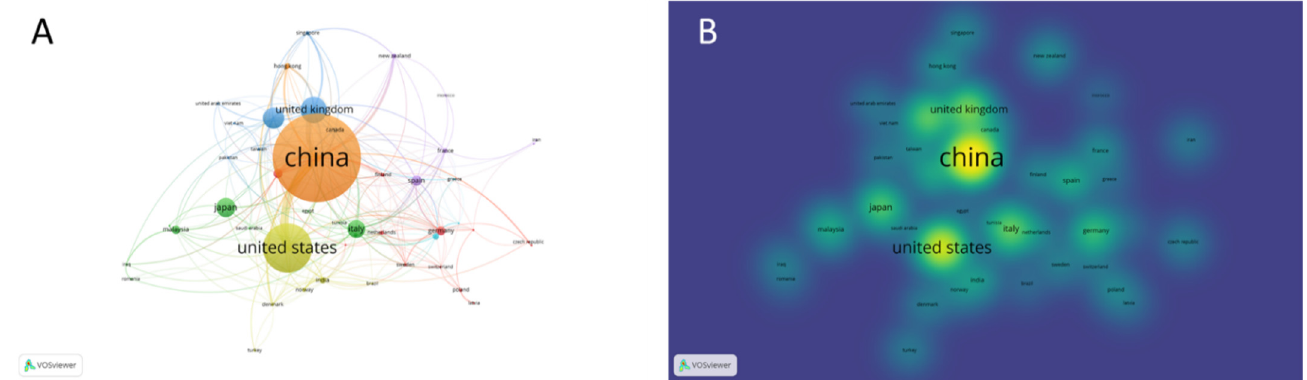
Figure 6. Co-authorship analysis for countries network ( A ) and density visualization ( B ). This network and visualization density maps (( A ) and ( B ) respectively) depicted the 47 items with 240 links and 7 clusters. 47 out of 77 countries met the criteria of at least five documents to be published by a country and minimum citations was set to zero.